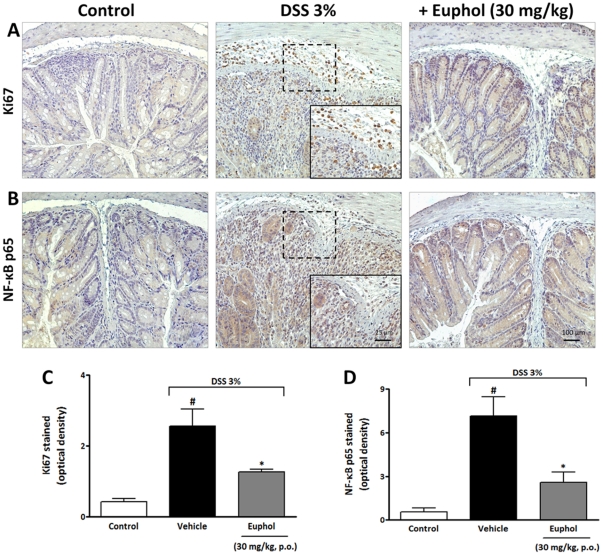
Euphol prevents inflammatory/enterocyte cells proliferation and NF-κB activation after DSS-induced colitis.Expression of Ki67 and phosphorylation of NF-κB was performed 7 days after administration of DSS (3%) or with vehicle in colonic tissues. Pre-treatment with euphol (30 mg/kg, p.o.), significantly inhibited proliferation index (Ki67) (A) and phosphorylation of p65 NF-κB (B) in colon tissue after DSS-induced colitis in mice. (A–B) Representative images of Ki67 and phospho-p65 NF-κB immunoreactivity in colon tissue. Scale bar corresponds to 100 and 25 mm (black square) respectively, and applies throughout. Graphical representation of the immunostaining for Ki67 (C) and phospho-p65 NF-κB (D) expression evaluated in colon tissue. The mean intensity of Ki67 and p65 NF-κB staining were determined from image analysis and are represented as optical density. Each column represents the mean ± S.E.M. of 8 to 10 mice per group and is representative of two independent experiments. #P<0.05 vs. control healthy group (non colitic); *P<0.05 vs. DSS-treated group.